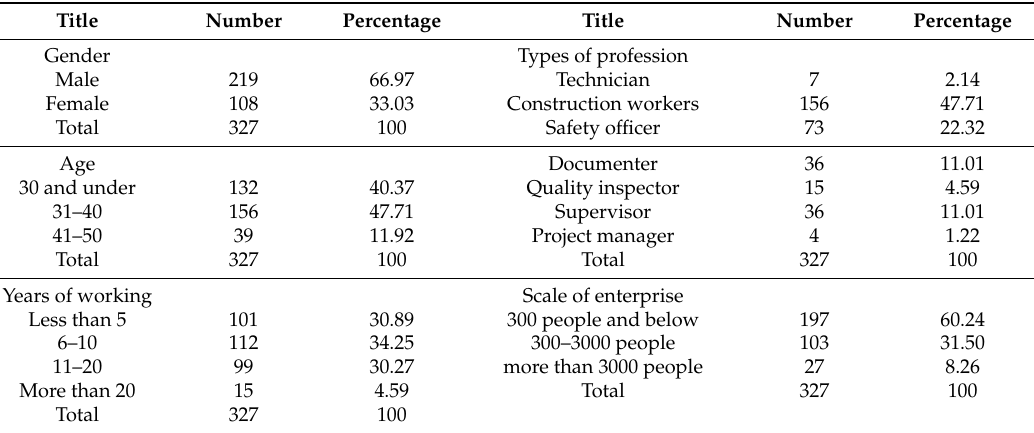
Table 1. Descriptive statistics of the